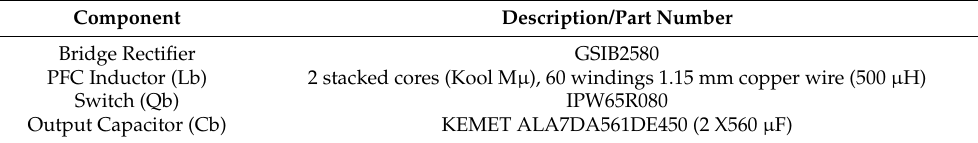
Figure 32. Prototype of the designed digitally controlled PFC boost converter. Table 3. Boost converter component’s specifications for the experimental